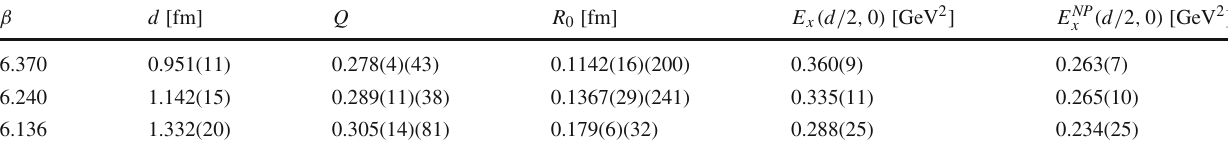
Table 2 Valuesof the fitparameters Q and R 0 extractedfrom Coulomb fits of the transverse components of the chromoelectric field and val- ues of the longitudinal chromoelectric fields at ( d / 2 , 0 ) , the midpoint between the sources and transverse distance zero, for several val- ues of distance d . E x ( d / 2 , 0 ) is the unsubtracted simulated field and